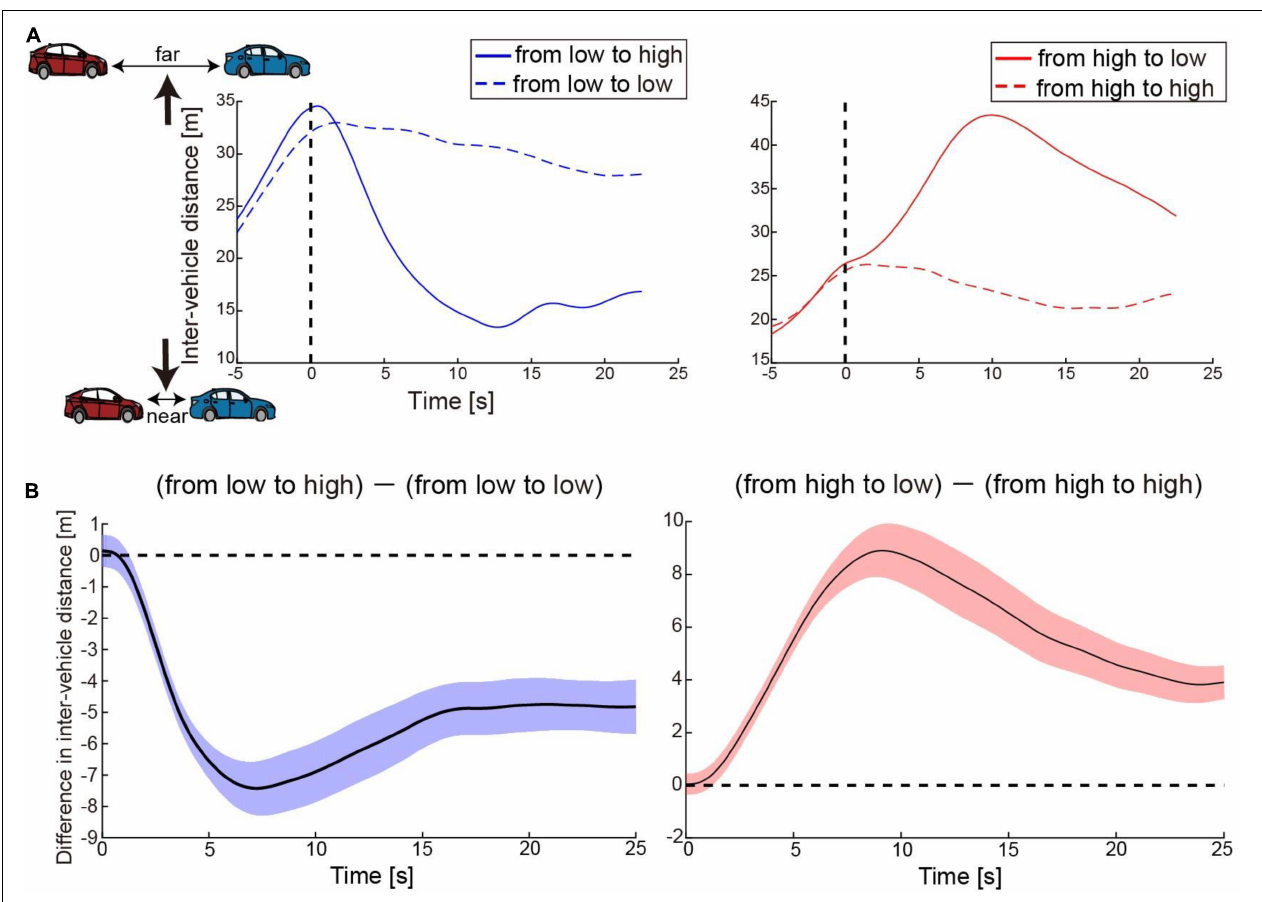
FIGURE 3 | Behavior results. (A) Time courses of inter-vehicle distance for one participant as an example. The solid blue and red lines denote time courses of the distance in the conditions when accelerator sensitivity changed from low to high and from high to low, respectively. By contrast, the dotted blue and red lines indicate time courses of the distance in the conditions where the sensitivity remained low or high, respectively. The distance was averaged across trials in each condition. The vertical dotted line denotes the timing at which his car passed the 500-m point of the straight section. In the change conditions, the level of accelerator sensitivity changed at this timing. (B) Time courses of difference in inter-vehicle distance between change and no-change conditions. The values were averaged across participants at every moment. Colored shaded areas indicate 95% confidence